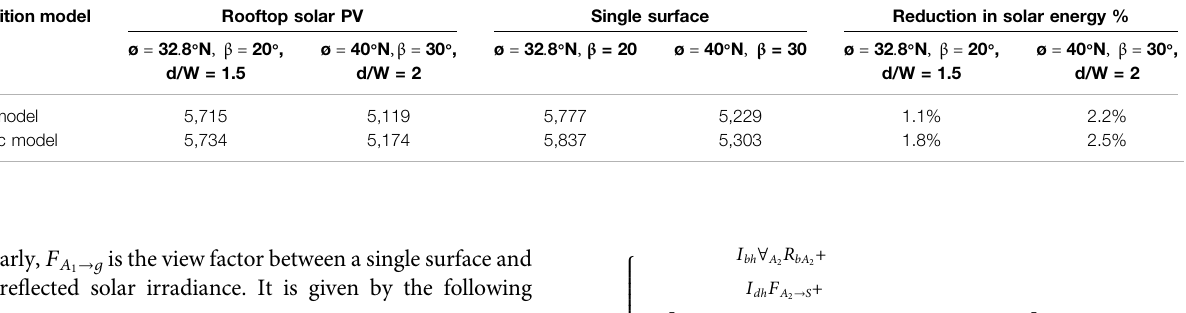
TABLE 5 | Daily solar radiation [W/m2/day] incident on rooftop solar PV installation ( L Transposition model Rooftop solar PV Single